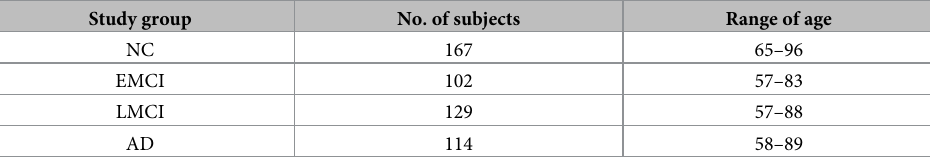
Table 1. Overview of rs-fMRI study groups.